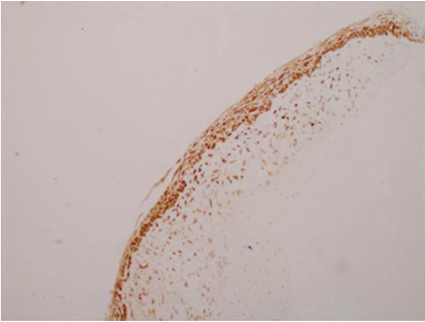
Figure 4: Immunohistochemical analysis of the cyst: pancytoker- atin positivity at squamous epithelium (pancytokeratin ×